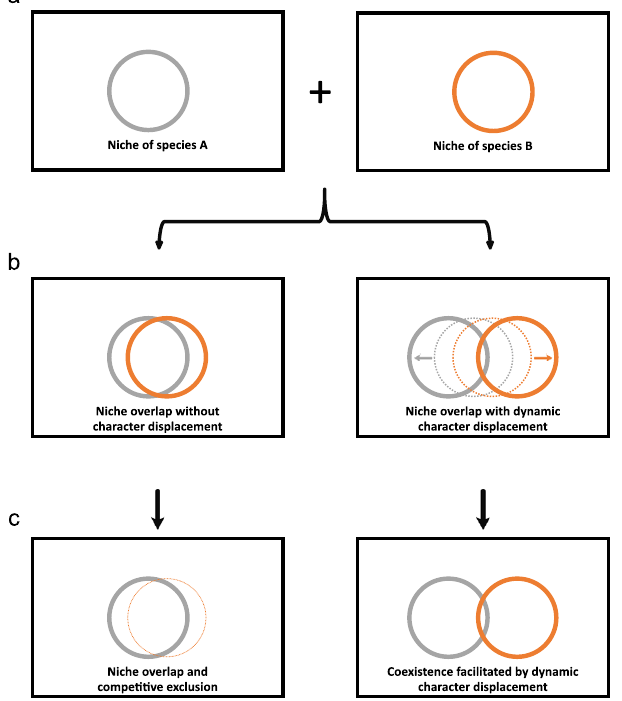
Fig. 1 Conceptional overview of niche occupancy by bacteria colonizing the plant in mono-association and upon coexistence. a General niche of two species, A (gray) and B (orange), in case they do not encounter each other in a given habitat. b During co-occurrence, the niches of the two species overlap substantially, leading to competition for shared resources (left) but also to potential for a dynamic character displacement (right, indicated by arrows). c As a consequence, one species may displace the other species from the niche resulting in competitive exclusion (left). Alternatively, a dynamic character displacement may occur, reducing the original niche overlap and leading to coexistence (right). The size of the circle indicates productivity in the ecological niche. In this study, niche occupancy was measured using a proteomics